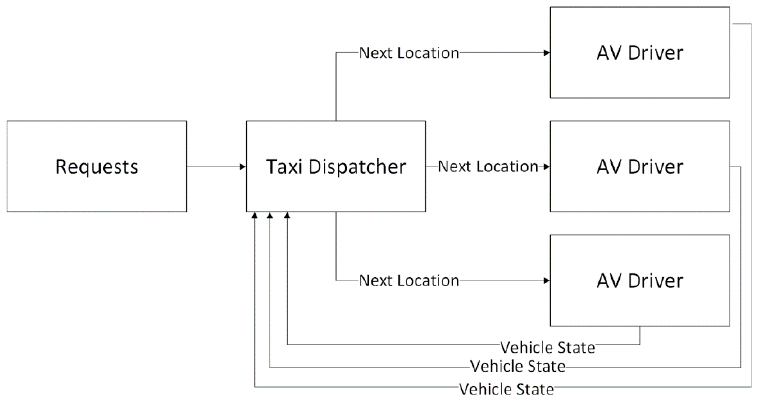
Figure 7. Three SAVs regarded as extensions of AVs by adding a centralized upper-level controller.